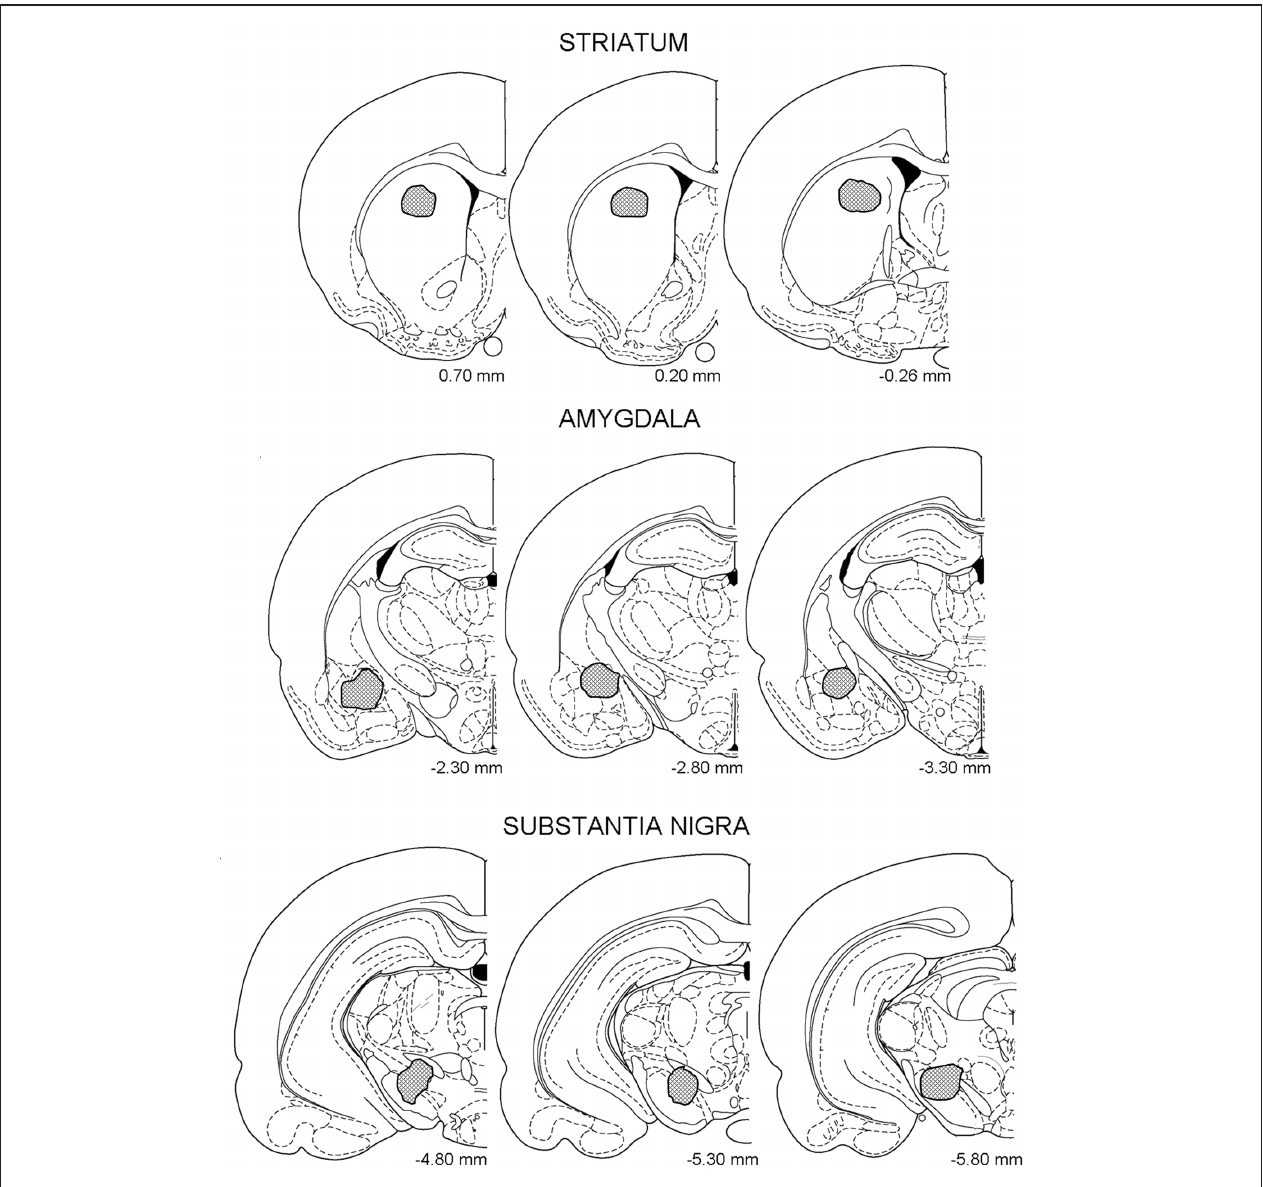
FIGURE 1 | Hatched areas represent location of cannula tips within the striatum, amygdala, and substantia nigra. Redrawn from ).